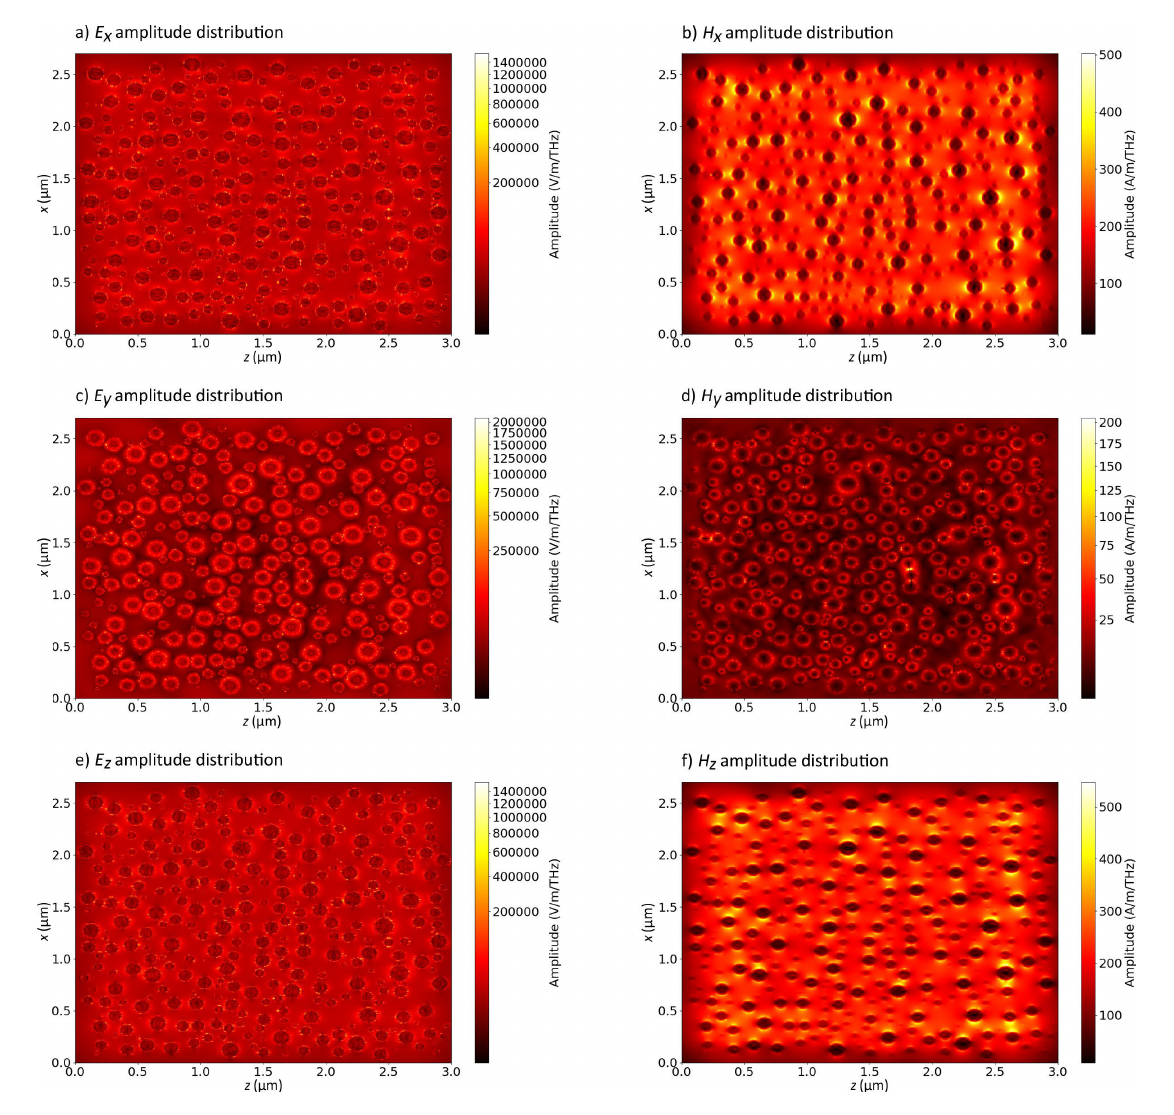
Figure 14: Calculated amplitudes of the components of the electromagnetic field in the plane where the nanoparticles are placed. The incident light at wavelength 460 nm is unpolarized. From (a) to (f): E x , H x , E y , H y , E z and H z .